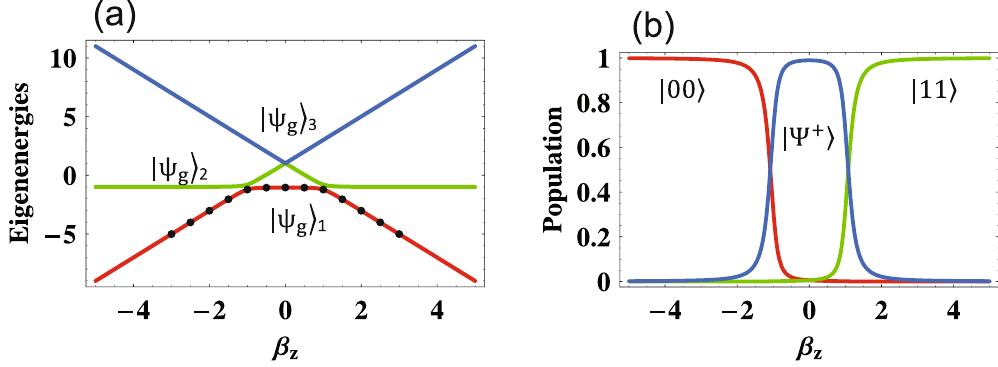
Figure 1. Theoretical predictions. ( a ) Energy spectrum for the two-spin Ising chain (an isolated dimer) as a function of the dimensionless field strength β z and a fixed β x = 0.15. We experimentally simulate the ground state | ψ g 〉 i of the Ising spin model with the certain dimensionless field strengths { β x , β z } = {0.15, 0}, {0.15, ± 0.5}, {0.15, ± 1}, {0.15, ± 1.5}, {0.15, ± 2}, {0.15, ± 2.5}, {0.15, ± 3}. ( b ) Populations of |00 〉 , |11 〉 and | Ψ + 〉 in the ground state | ψ g 〉 i v.s. β z